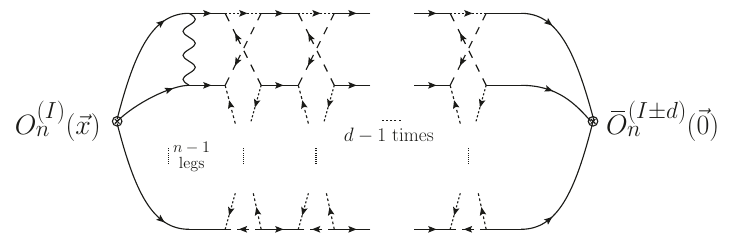
Figure 4 : The diagram describing the next-to-leading contribution to (cid:10) O ( I ) n ( ~x ) O ( I ± d ) n ( ~ 0) (cid:11) . This contribution is proportional to λ nd +1 ζ (2 n − 1) d − 1 ζ (2 n + 1)